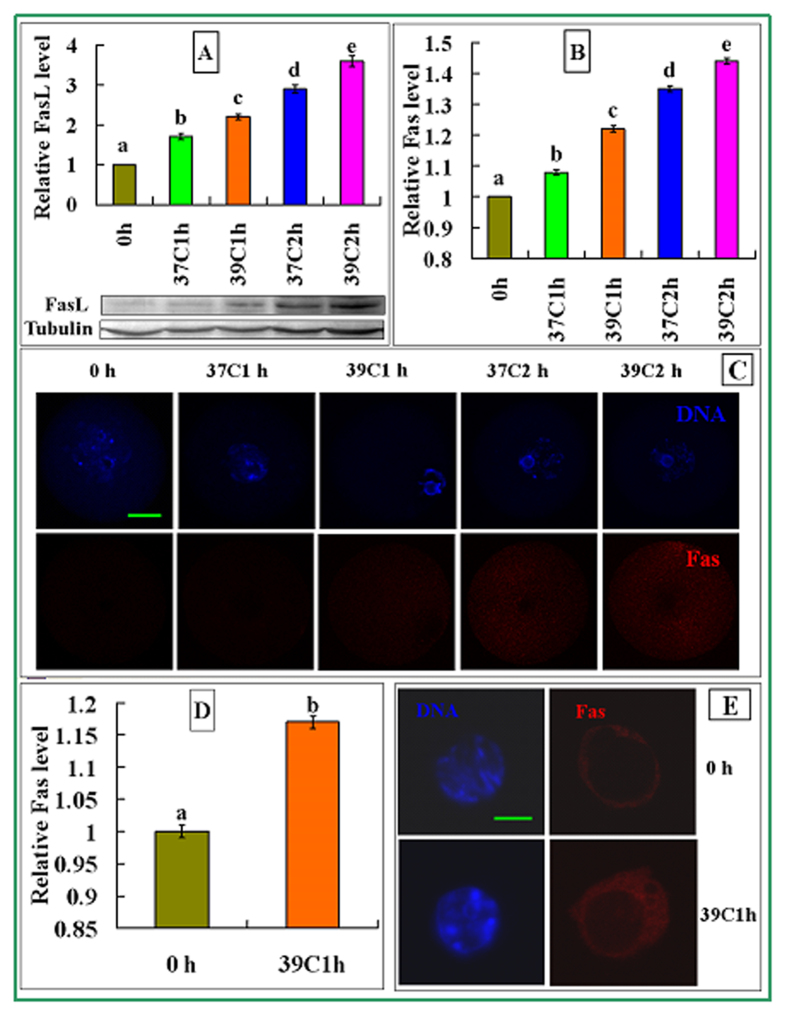
Levels of FasL in MGCs and Fas receptors in oocytes and cumulus cells after OH of prepubertal mouse ovaries.The OH conditions include before OH (0 h) and after OH at 37 °C for 1 h (37C1h), 39 °C for 1 h (39C1h), 37 °C for 2 h (37C2h) and 39 °C for 2 h (39C2h). Panel A shows FasL expression in MGCs revealed by western blotting. The molecular weights of FasL and β-tubulin (Tublin) are 31 and 55 kDa, respectively. Panel B shows Fas quantification by immunocytochemistry in oocytes. Each treatment was repeated 3–4 times with each replicate containing about 30 oocytes. Panel C shows confocal micrographs showing Fas localization in oocytes. Original magnification ×400. Scale bar is 30 μm. Panel D shows Fas quantification in cumulus cells by immunocytochemistry. Each treatment was repeated 3–4 times with each replicate containing about 30 cells from 15 images. Panel E shows confocal micrographs showing Fas localization in cumulus cells. Original magnification ×650. Scale bar is 5 μm. In the confocal images, DNA and Fas were pseudo colored blue and red, respectively. In the graphs, a–e indicates values without a common letter above their bars differ significantly (P < 0.05).